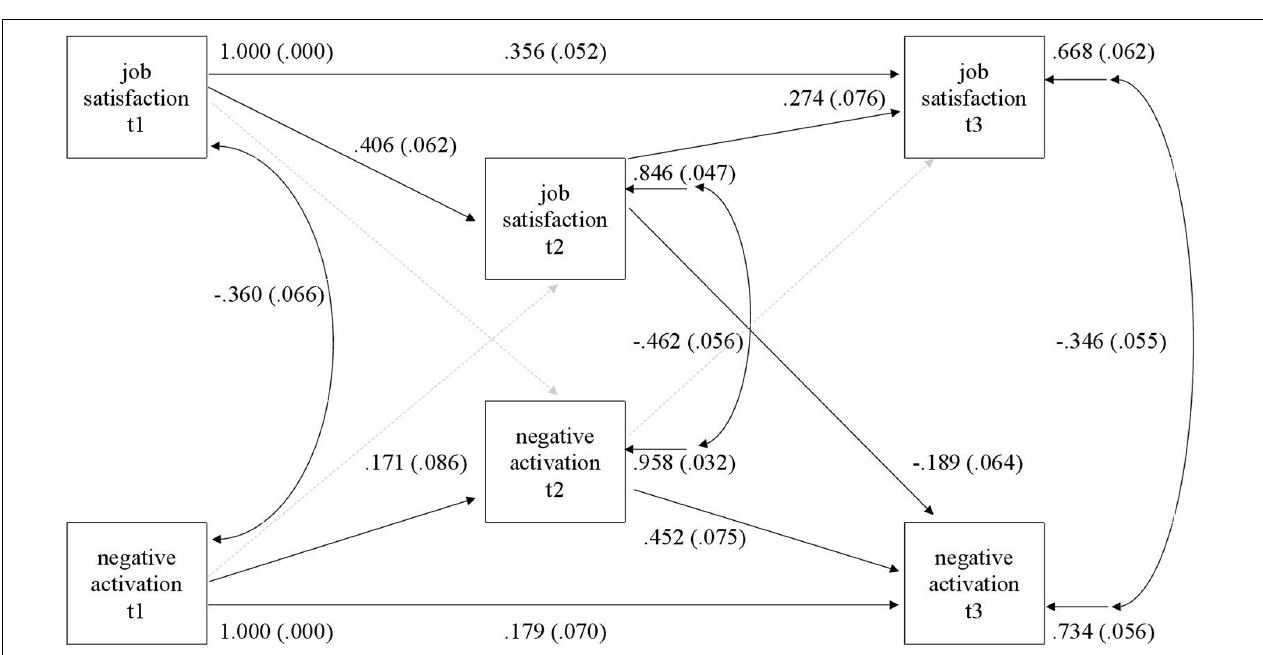
FIGURE 5 | Structural equation model (SEM) model of job satisfaction and negative activation. A dashed line indicates that the path is not statistically